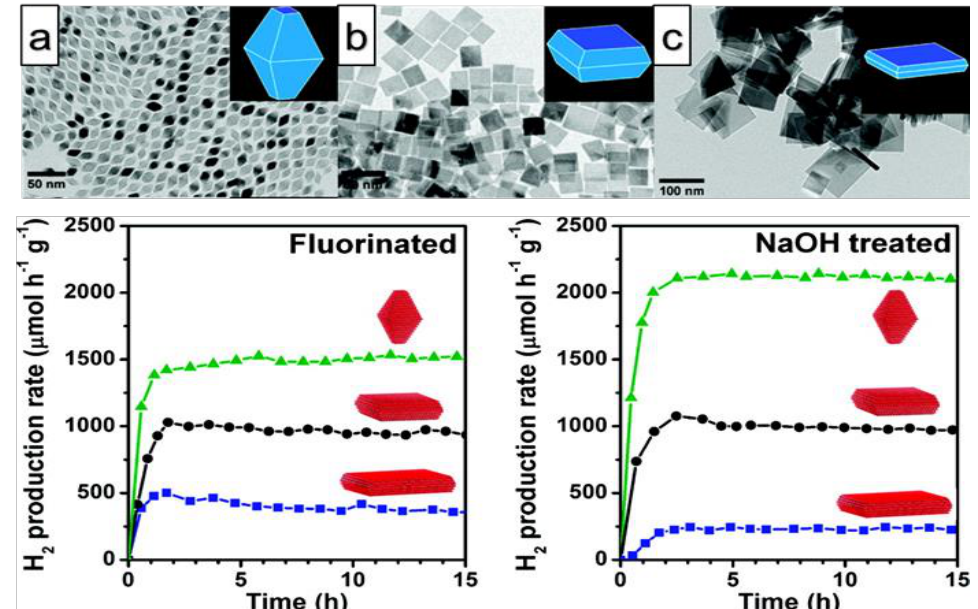
Figure 10. Top : TEM images of TiO 2 nanocrystals synthesized ( a – c ). Bottom : H 2 production rate over fluorinated and NaOH-treated materials. Adapted with permission from [49]. Copyright © 2012 American Chemical Society.